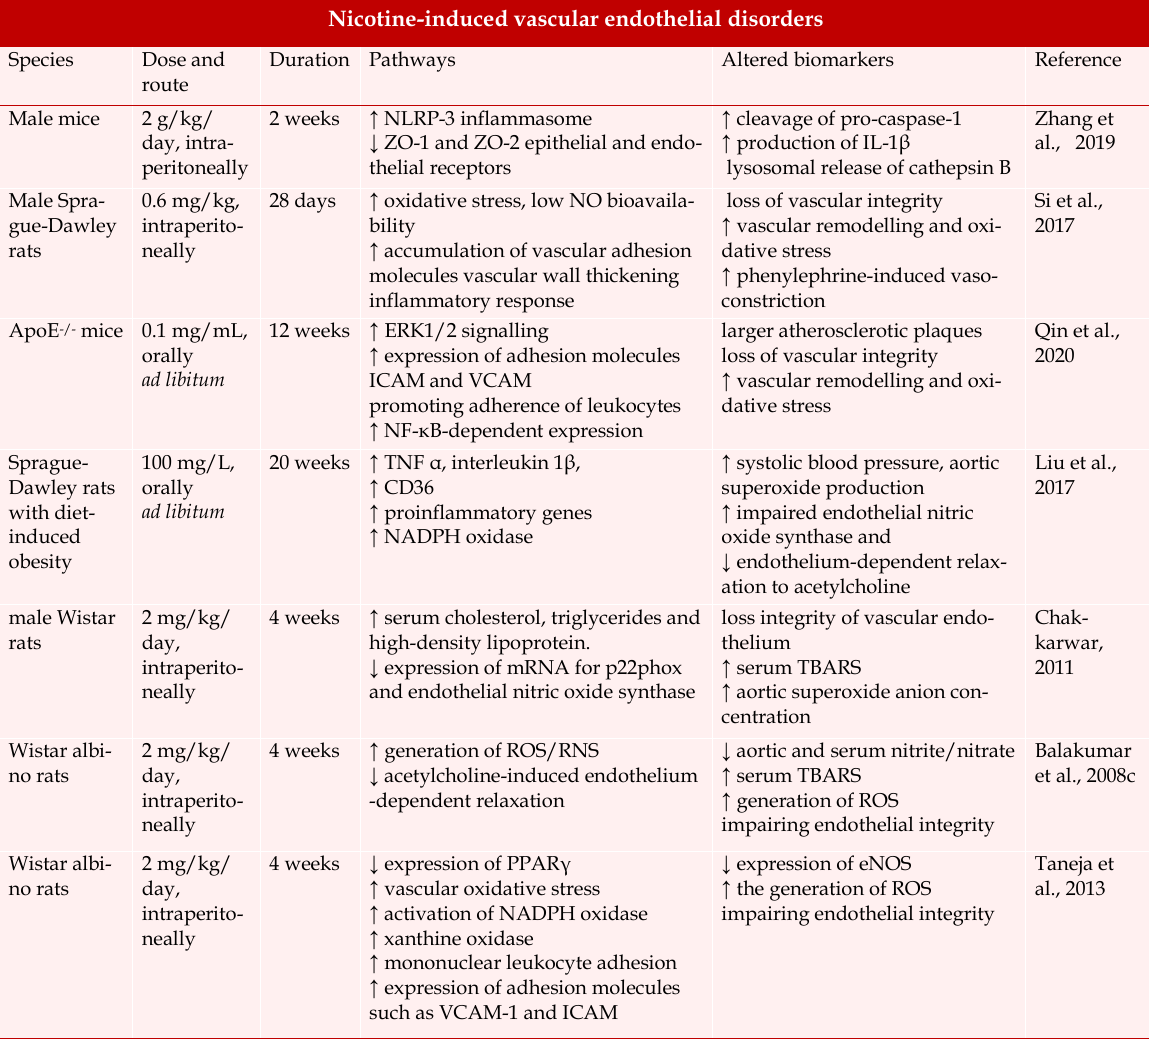
Nicotine-induced vascular endothelial